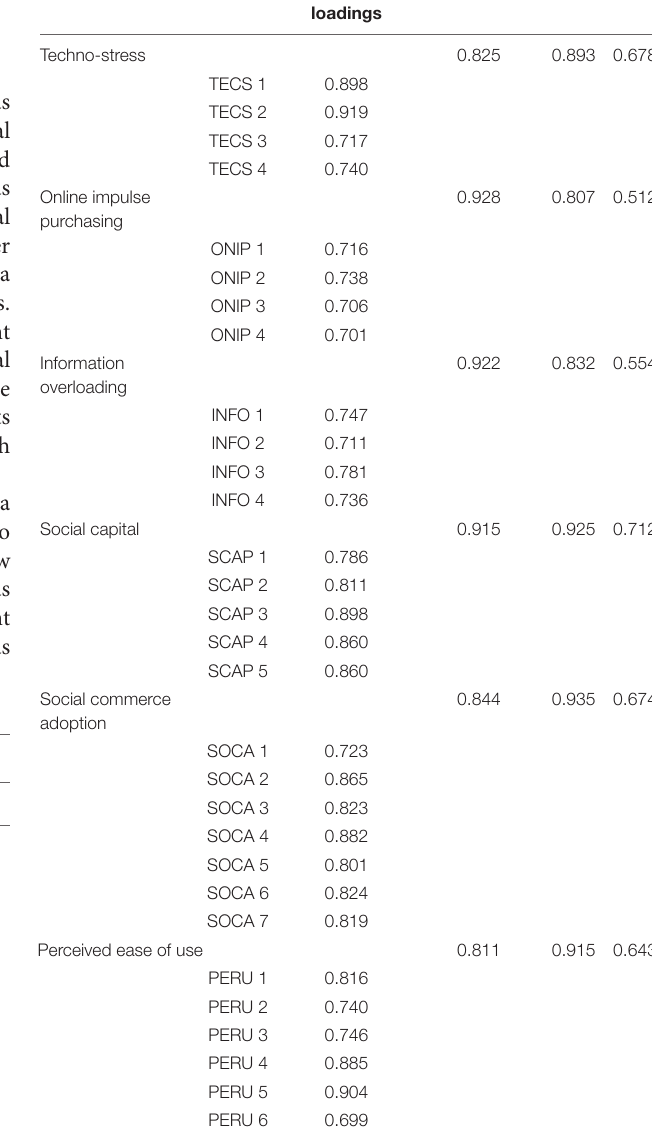
TABLE 4 | Results of reliability and validity